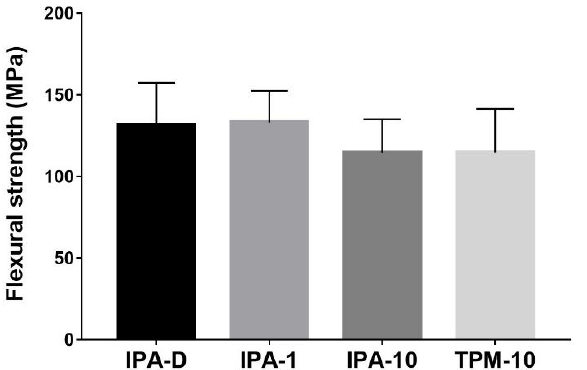
Figure 7. Flexural strength according to different washing conditions.